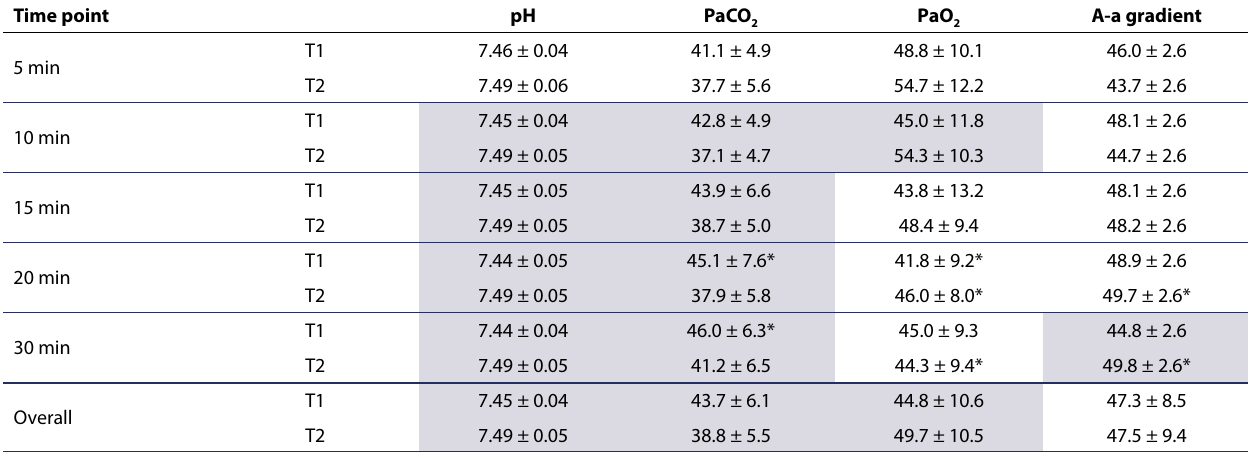
Table III: Blood gas variables (mean ± SD) recorded during immobilisation of blesbok with T1 (etorphine + azaperone) and T2 (etorphine + midazolam) Time point